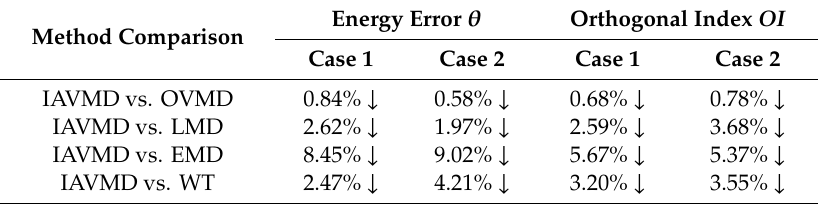
Table 5. Thepercentagedifferencesofthe IAVMD with respect tootherapproachesinthe simulationsignal.